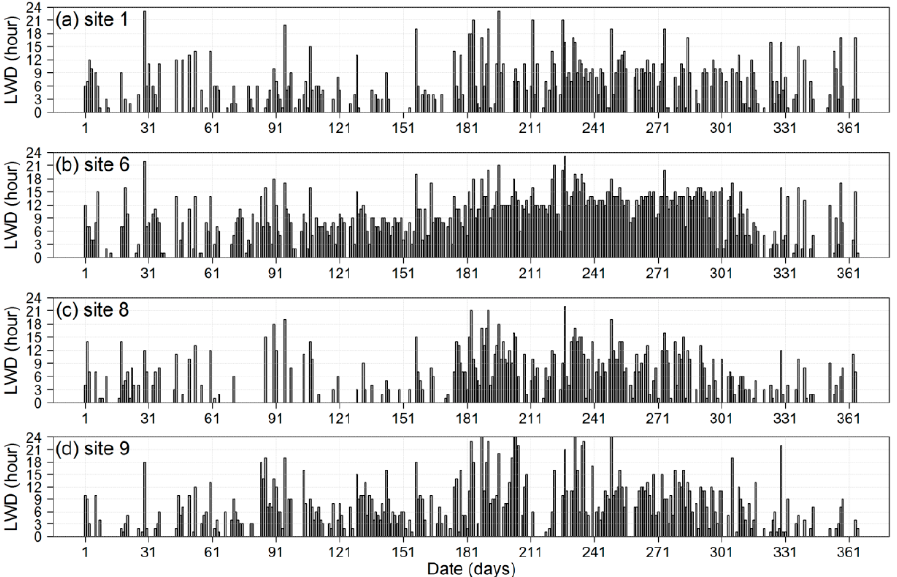
Figure 2. Time series plots of LWD observations for four sites in 2017.